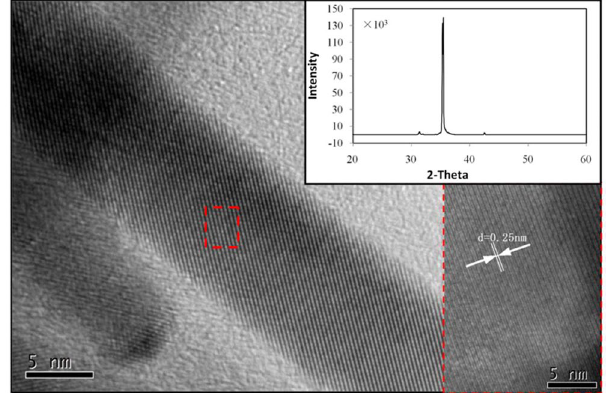
Figure 6. The HRTEM image of ITO nanowire. The inset is the XRD spectrum of ITO nanowire